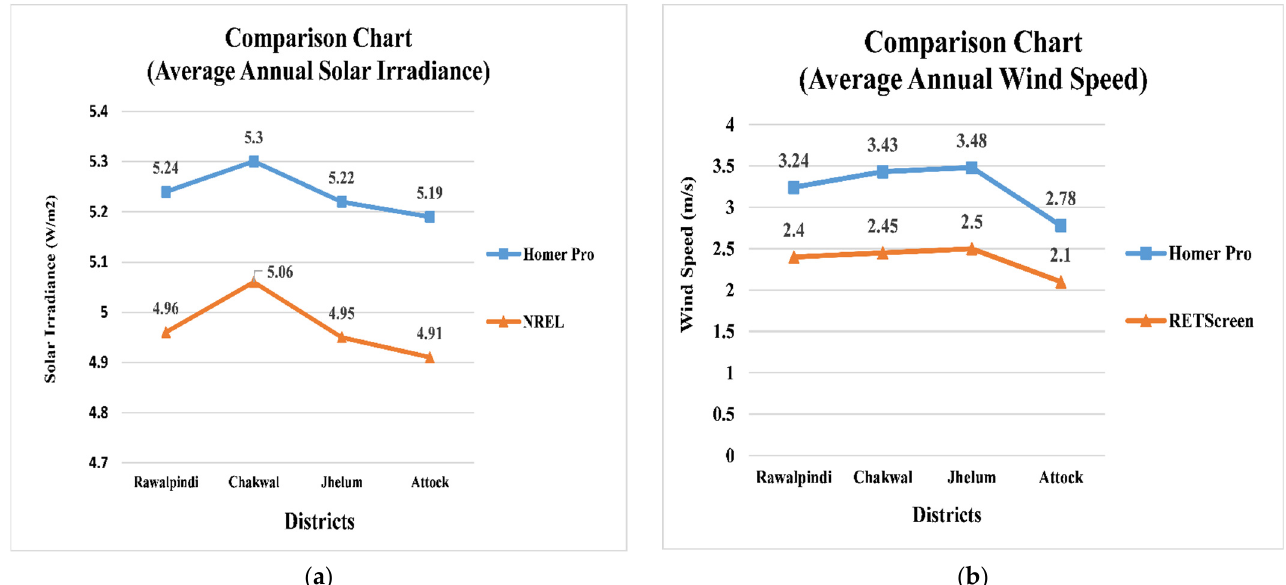
Figure 3. Comparison chart of average annual solar irradiance and wind speed of study area ( a ) average annual solar irradiance ( b ) average annual wind speed.